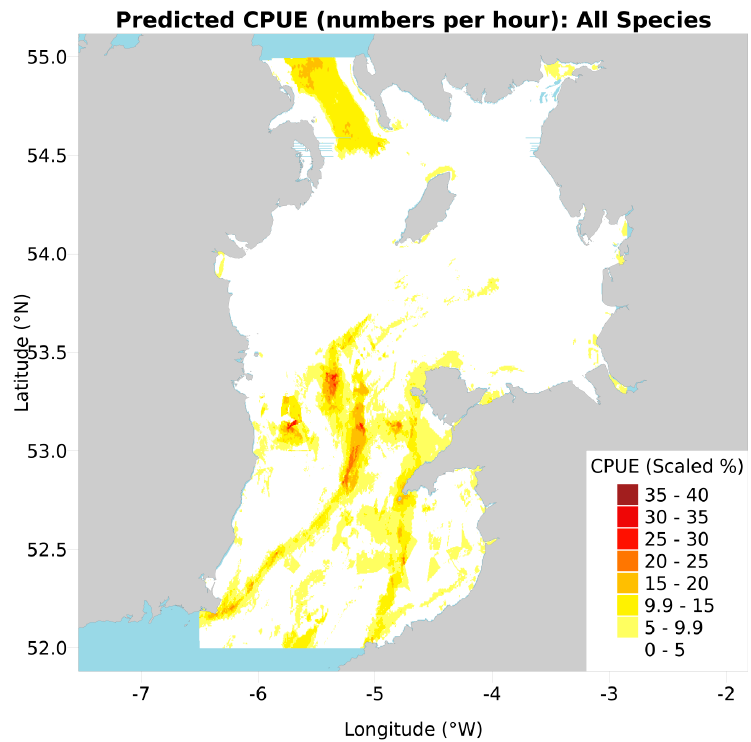
Figure 4. Model predicted combined CPUE of juvenile plus mature female rays for all species, each scaled to maximum CPUE per subset then summed, used to infer conservation value. Values are therefore a percentage of the maximum (100%) of all eight subsets, summed (800%, rescaled to 100%).